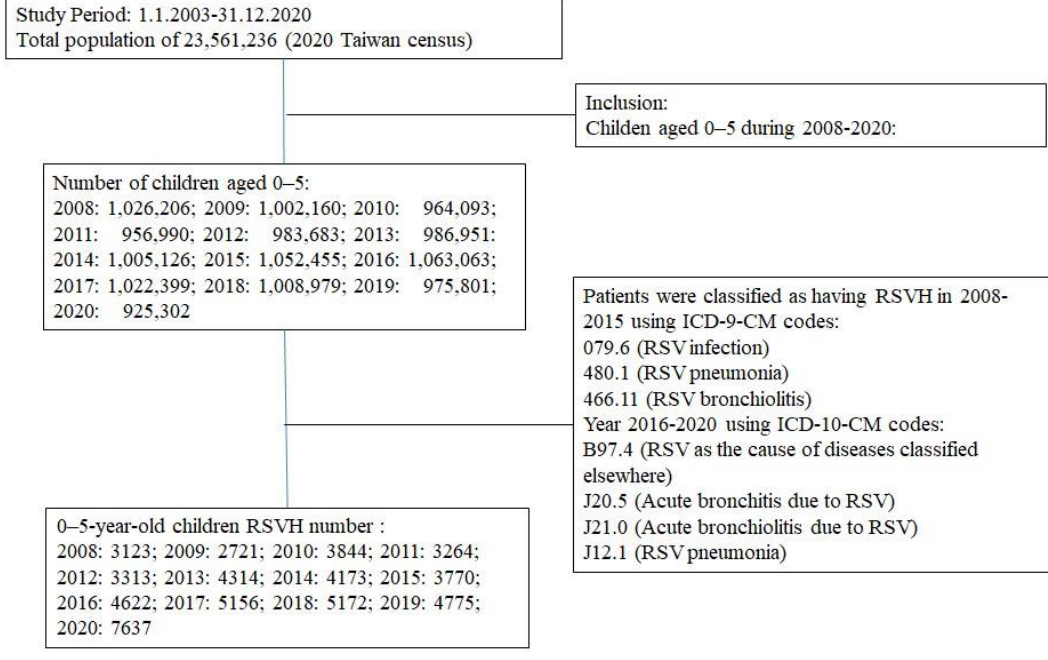
Figure 1. Enrolment flow chart.